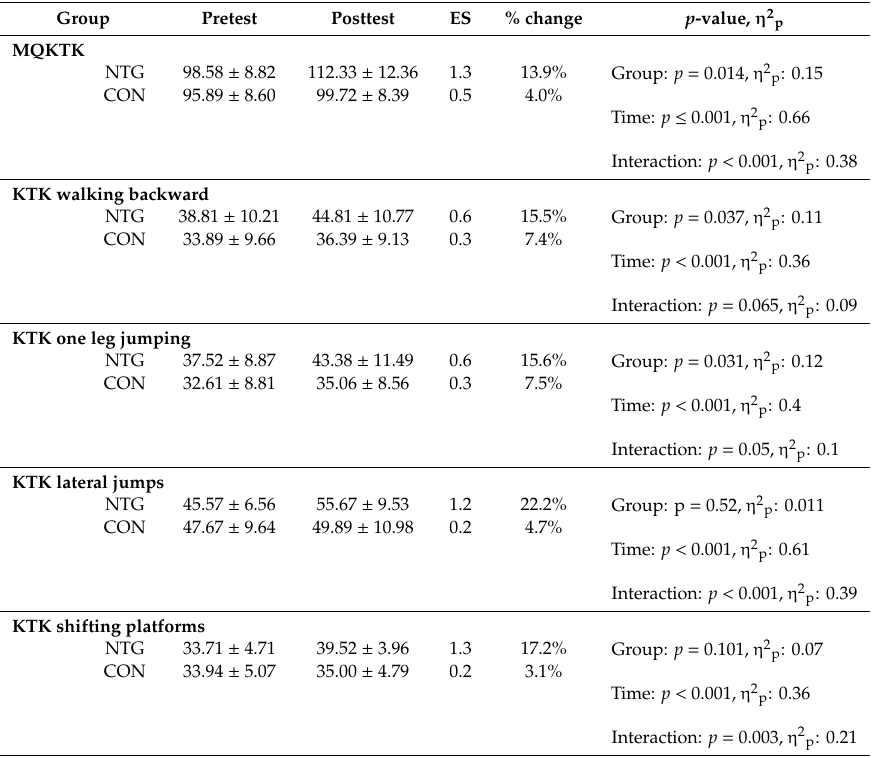
Table 3. Pretest and posttest results for motor competence.